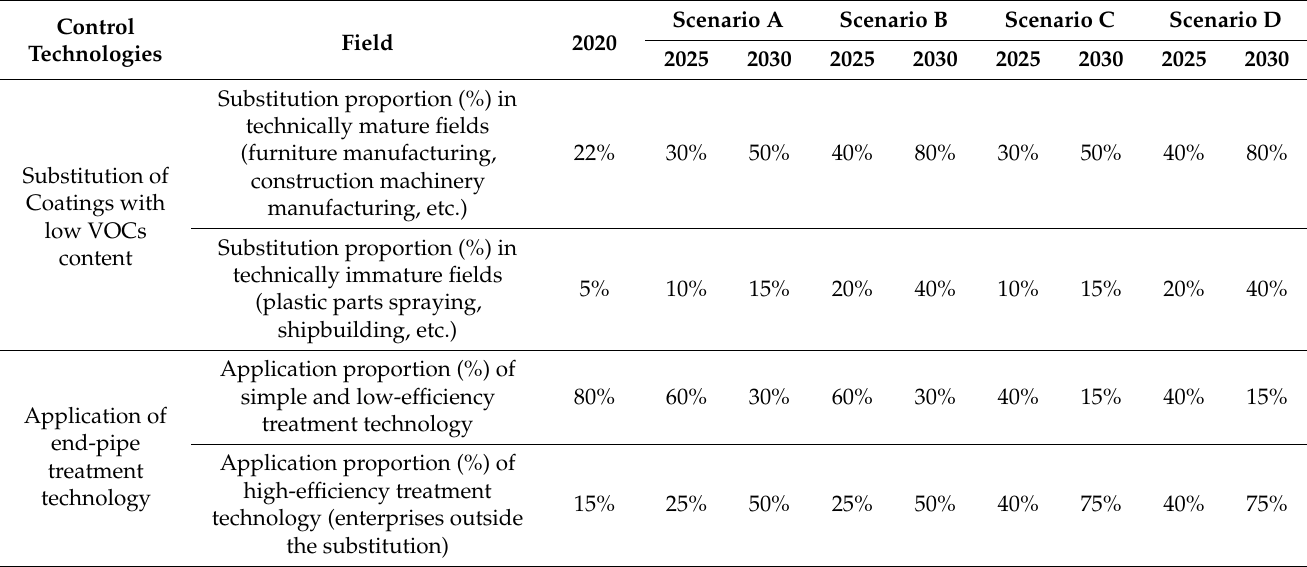
Table 6. The technology penetration of four scenarios in surface-coating industries for the years 2025 and